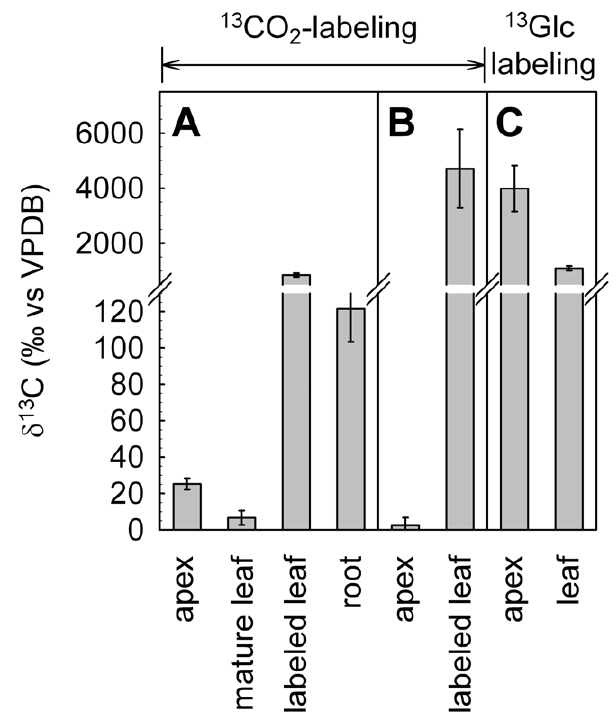
Figure 3. Analysis of d 13 C in bulk material of poplar. (A) Intact plants labeled with 13 CO 2 , (B) shoots labeled with 13 CO 2 , and (C) shoots fed with 13 Glc. Data represent the mean of 3 experiments 6 s.e.